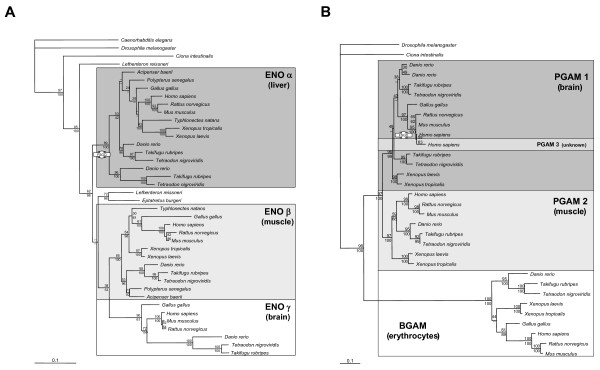
Maximum-likelihood tree of the heterodimeric composing glycolytic enzymes enolase (ENO), and phosphoglycerate mutase (PGAM) dataset comprising 40 amino-acid sequences for ENO (446 AA), and 32 amino-acid sequences for PGAM (256 AA). Values at the branches are support values (ML bootstrapping/MB posterior probabilities). 'FSGD' depicts putative fish-specific gene duplication events.